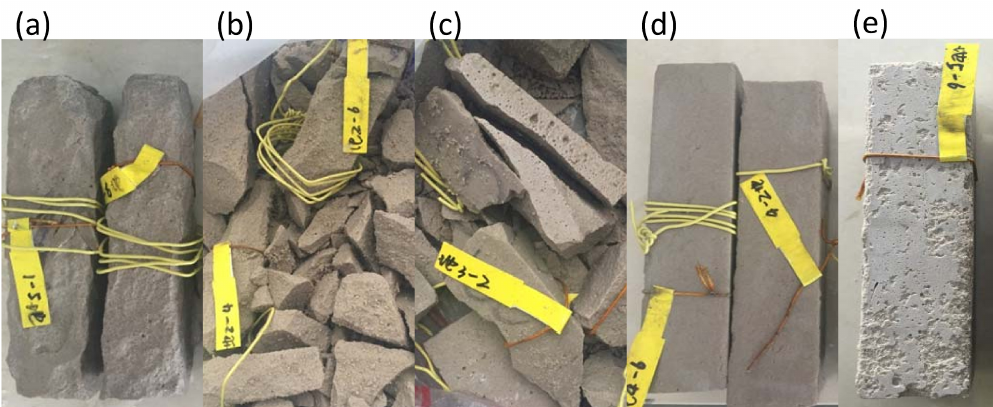
Figure 6. Pictures of the MKG mortars after 50 F-T cycles: ( a ) MKG-1; ( b ) MKG-2; ( c ) MKG-3; ( d ) MKG-4; and ( e ) MKG-5.